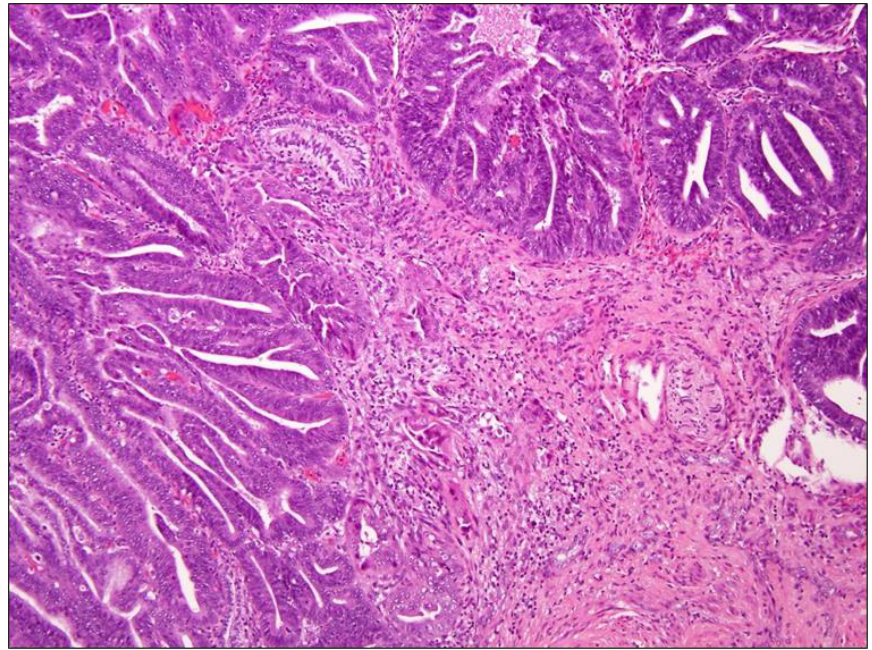
Figure 3. Endometroid carcinoma, Hematoxylin-Eosin, 10× magnification. The panel shows